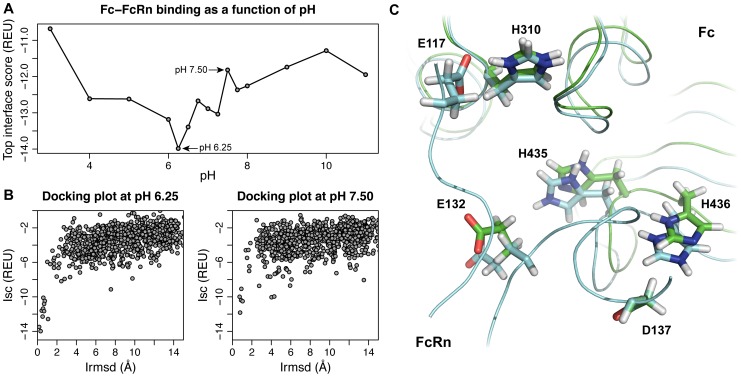
pH-dependent binding effects in Fc–FcRn complex.(A) Interface score of the top pHDock prediction for the Fc–FcRn complex as a function of the docking pH. (B) Interface score vs Irmsd plots generated using pHDock at pH 6.25 and pH 7.50. (C) Top pHDock models at pH 6.25 (cyan) and pH 7.50 (green) showing the three critical ionic interactions responsible for the large pH-dependent binding affinity change. Note the change in the protonation states of His-435 and His-436.